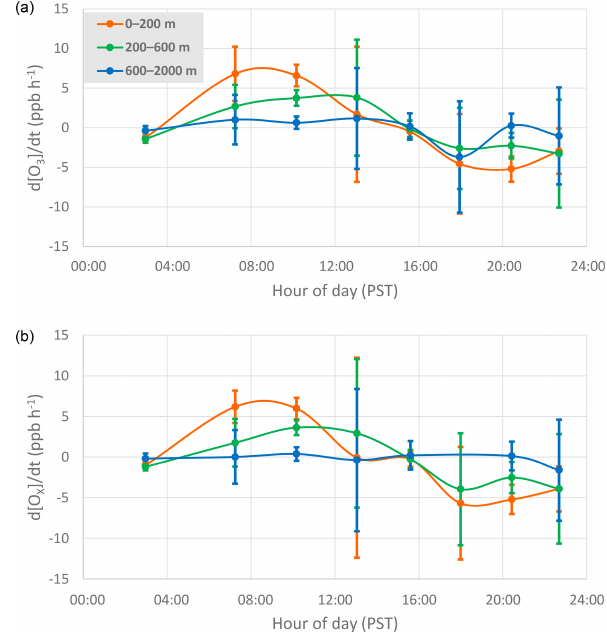
Figure 9. The average time rate of change of (a) O 3 and (b) O x over a complete diurnal cycle. The curves are cubic polynomial in- terpolations between averaged data points from the RLO flights over each 2h measurement period and intervals in between flights. Data are binned into three altitude layers: the lower boundary layer 0– 200m, the upper boundary layer 200–600m, and the buffer layer 600–2000m. Vertical bars around each point represent a standard deviation of the 15 flight sequences.